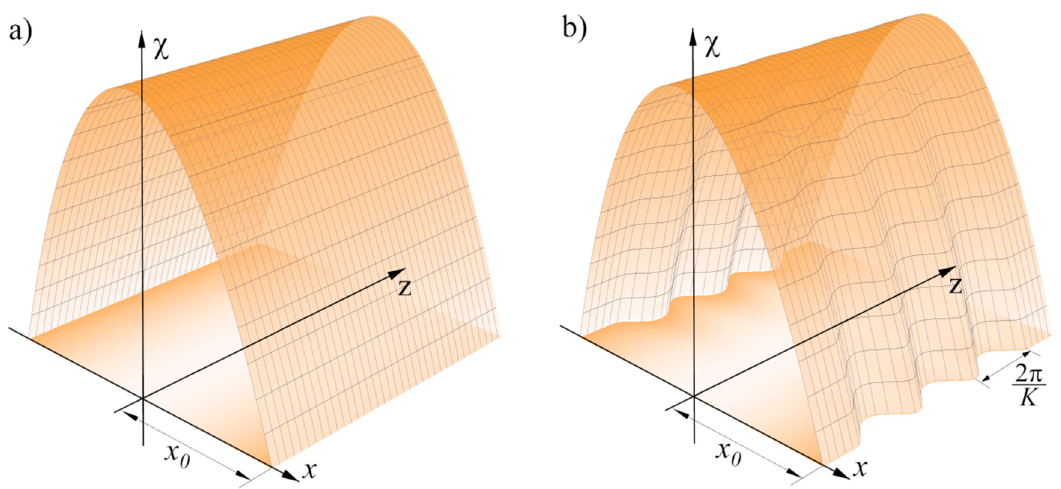
Figure 1. The schematic view of the planar waveguide structure with a near-parabolic profile of susceptibility χ ( x ) . The core of the waveguide is characterized by susceptibility with values greater than the near-boundary layers ( a ). Such a structure is similar to the harmonic oscillator in quantum mechanics and can be used for transportation along the z -direction of electromagnetic beams in the near-axis area without spatial shape deformation or distortion. The spatial modulation of the susceptibility (with a period 2 π / K ) can be used for e ffi cient excitation of the transverse beam structure, namely to build-up of a coherent or spatially squeezed state ( b ).